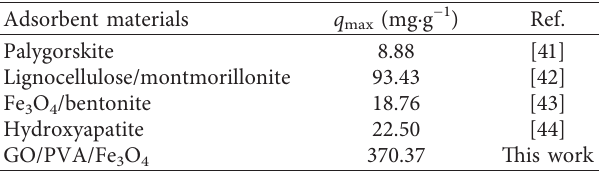
Table 5: Comparison of various adsorbents for Co 2+ ion